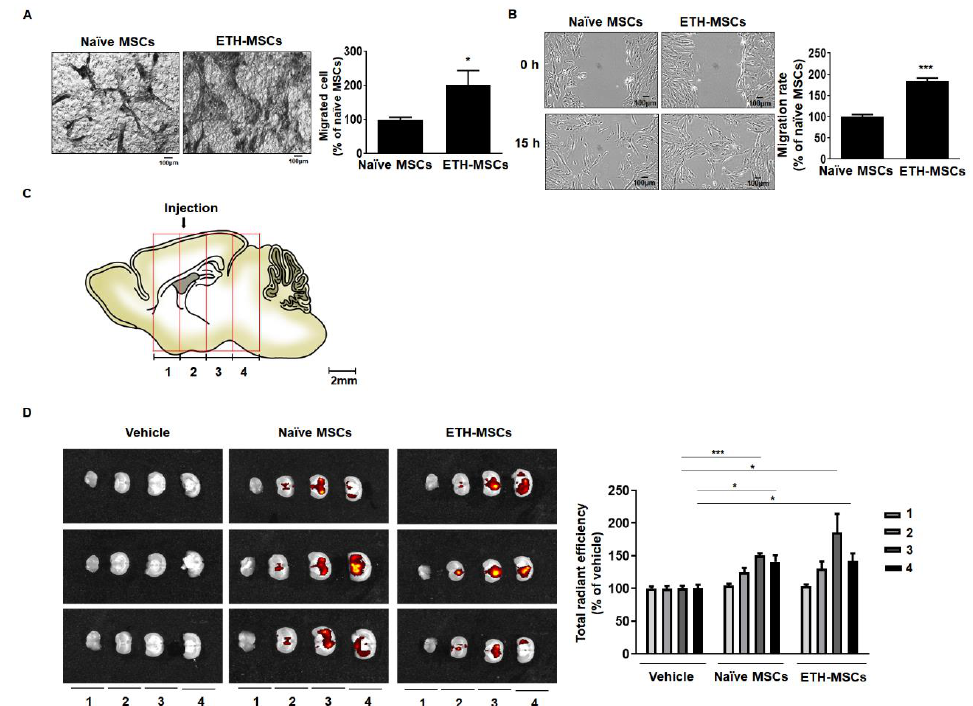
Figure 3. Ethionamide increased the migration ability of MSCs. The migration ability of MSCs was measured by the Boyden chamber assay and wound healing assay in vitro. ( A ) MSCs were cultured in transwell with 0.8 um pore size and after 24 h, migrated cells were stained with hematoxylin. ( B ) A representative image obtained after scratching the surface of 100% confluent MSCs and after 15 h, narrowed gap was measured using Image J. ( C ) The migration ability of MSCs was measured ex vivo. After injection, the mouse brain tissues were divided into four regions. ( D ) The maintenance of MSCs in each region was monitored by optical imaging. Results obtained from three independent experiments are expressed as percent of naïve MSCs or vehicle ± SEM; * p < 0.05 and *** p < 0.005 vs. naïve MSCs or vehicle control. Vehicle; the media used to resuspend the MSCs for injection. Scale bars = 100 µ m. Int. J. Mol. Sci. 2020 , 21 , x FOR PEER REVIEW